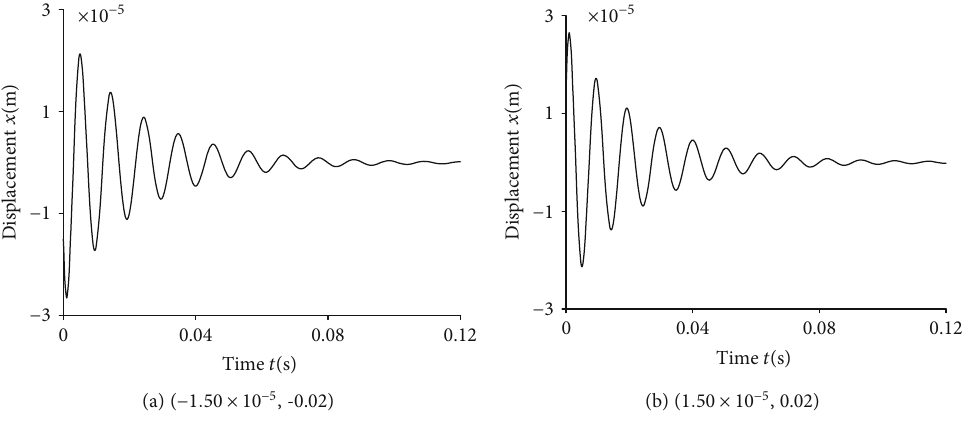
= 5 : 0 × 10 − 5 m , l = 5 : 0 × 10 − 5 m . 0